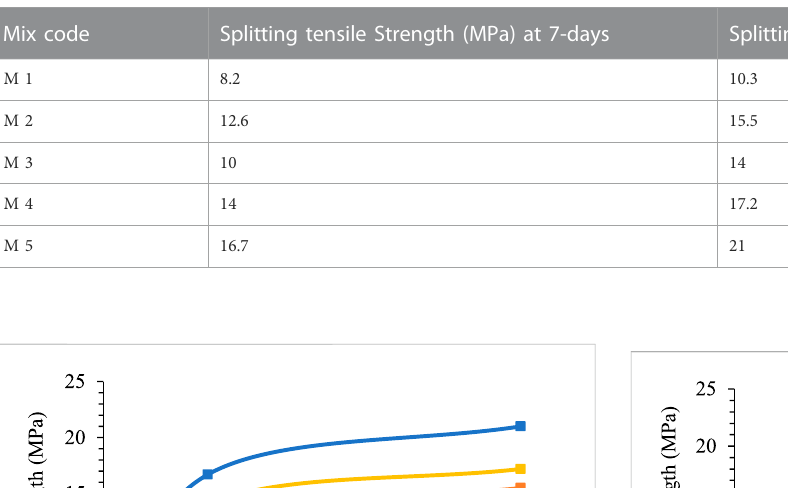
TABLE 8 Splitting tensile strength results.